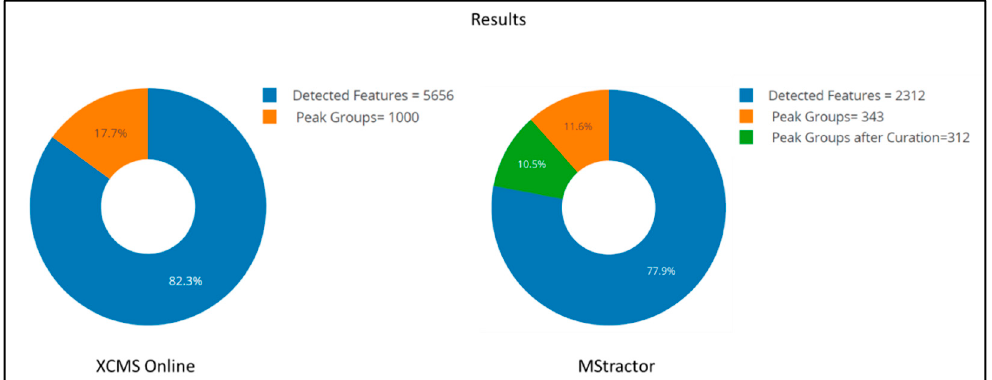
Figure 3. Result comparison for XCMS Online and